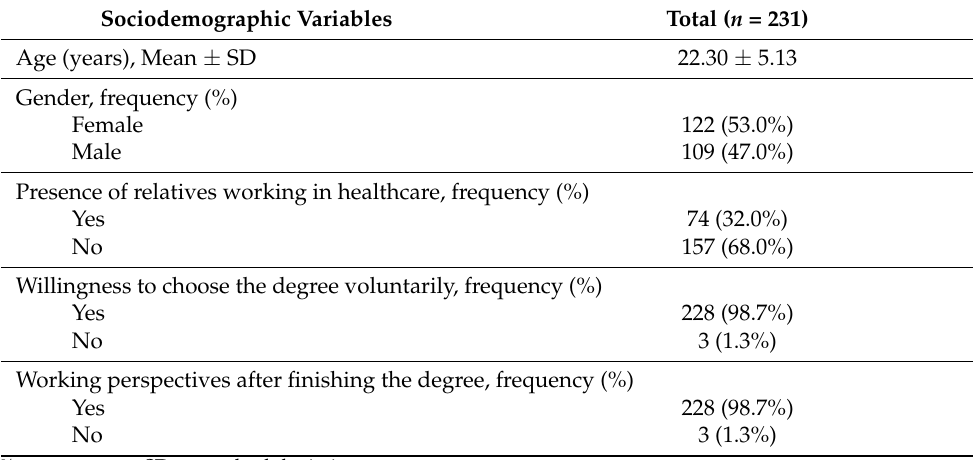
Table 1. Sociodemographic variables of the sample.